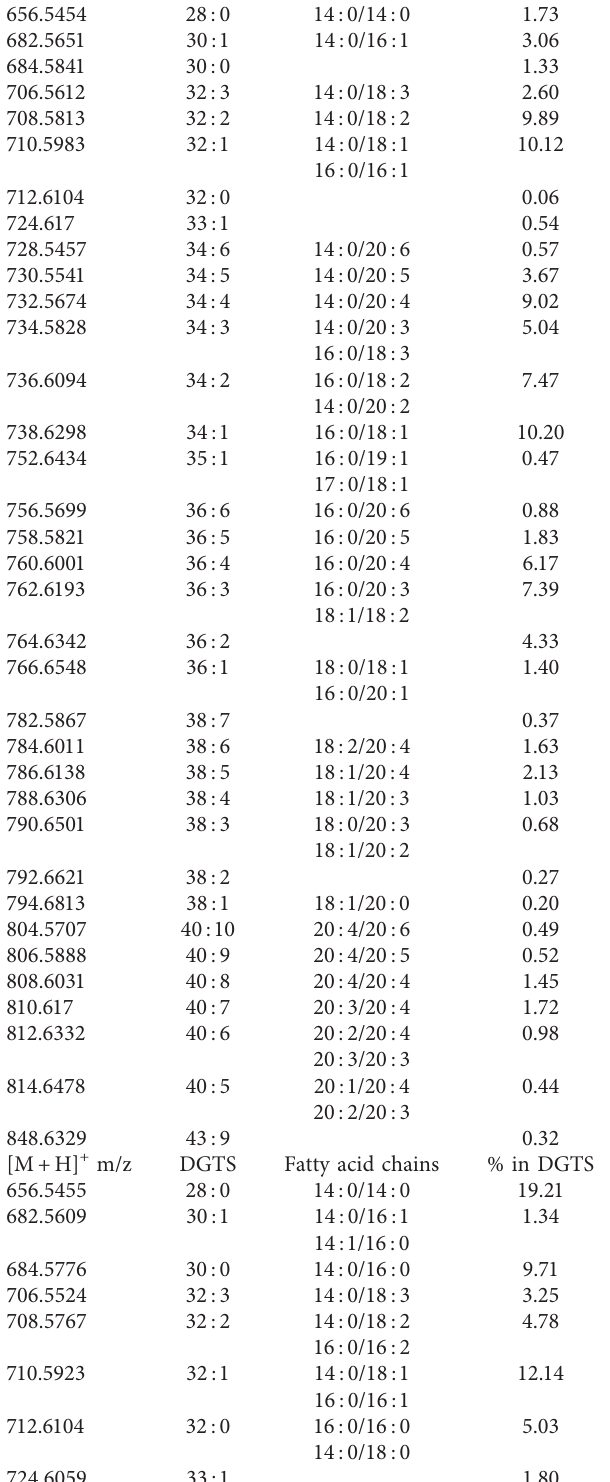
Table 5: Molecular species of betaine lipid including DGTA and DGTS groups identified by HPLC-HRMS as positive [M +H] + ion, and identification as phospholipid and fatty acyl composition confirmed by the analysis of the LC-MS/MS spectra of each